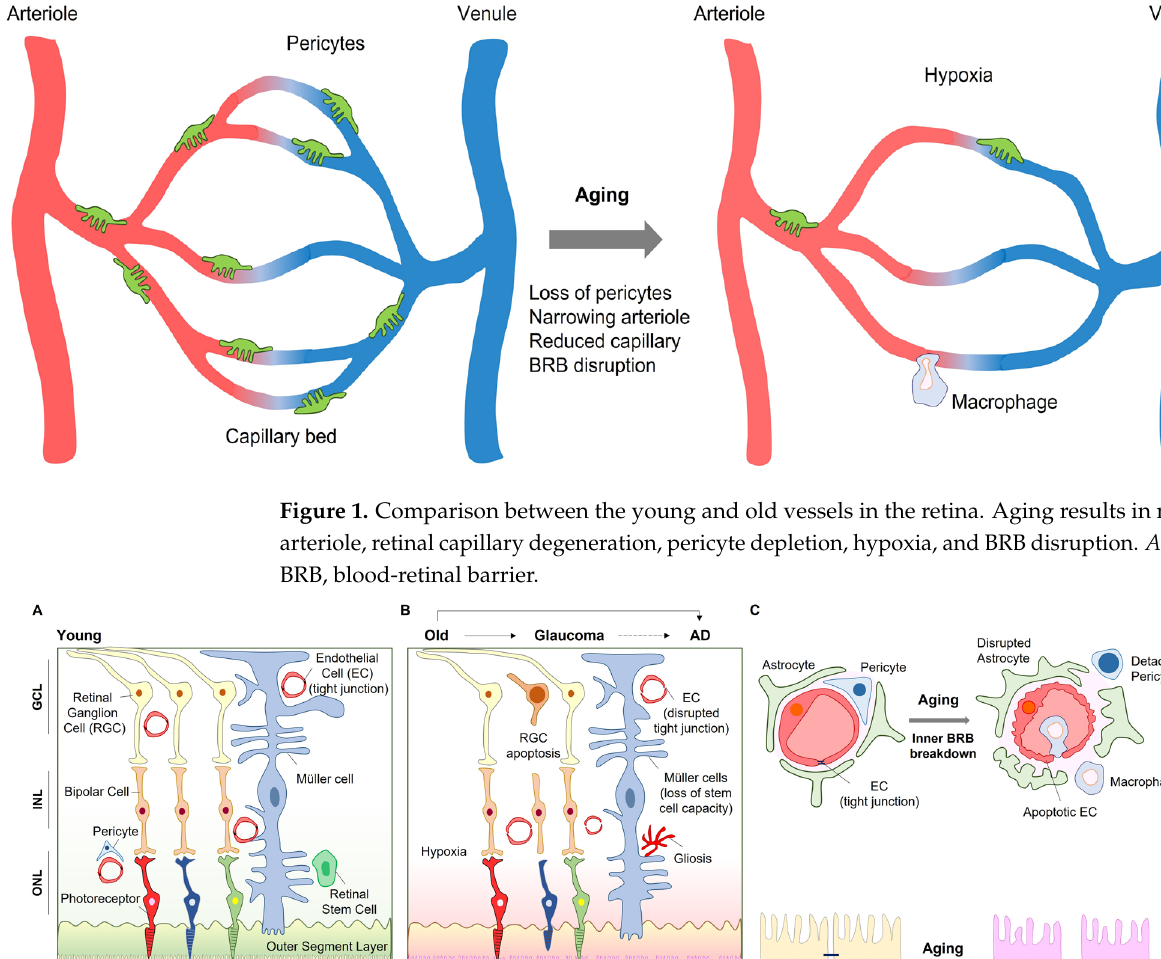
Figure 1. Comparison between the young and old vessels in the retina. Aging results in narrowing arteriole, retinal capillary degeneration, pericyte depletion, hypoxia, and BRB disruption. Abbrevia- tion . BRB, blood-retinal barrier.